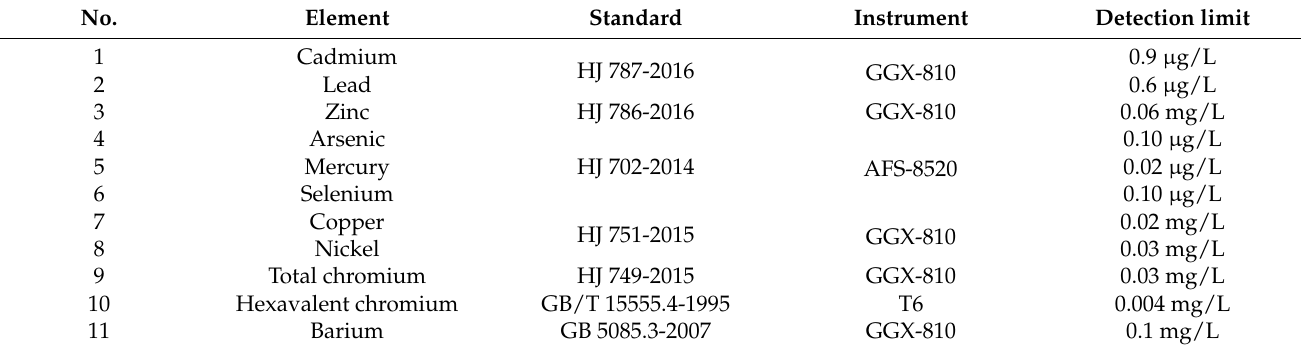
Table 1. The specific determination standards and instruments in the composition analysis of infiltration